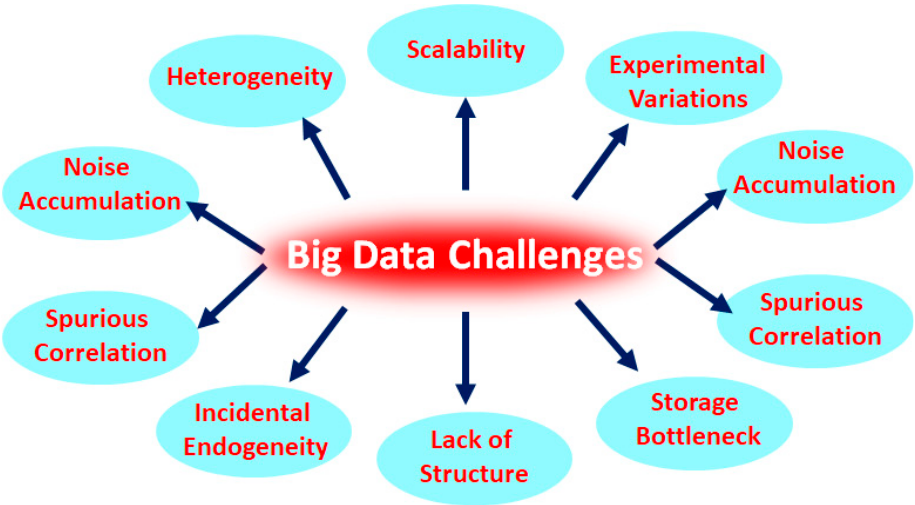
Figure 3. Big data challenges in recent